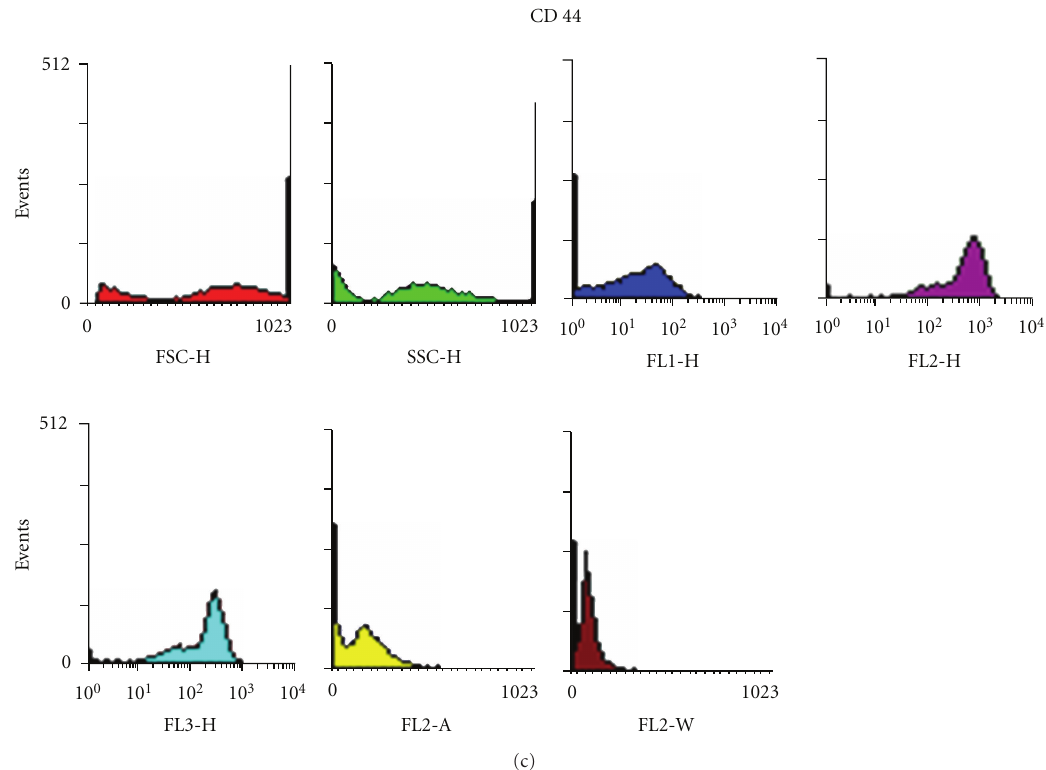
Figure 2: Flow cytometry analysis of CD 105, CD 90, and CD 44 in rat MSCs. Results represent three independent experiments.